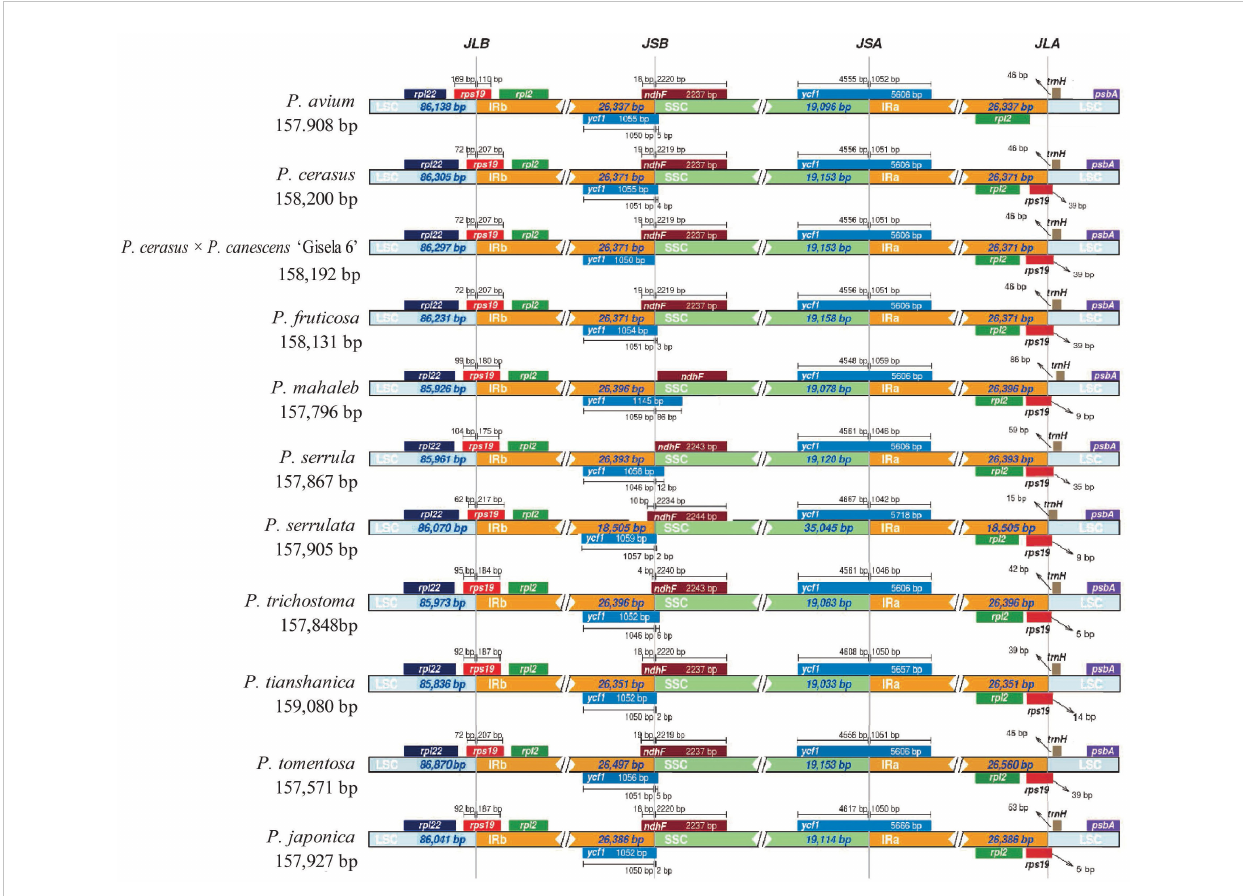
FIGURE 3 Comparison of the inverted repeat (IR)/large single copy (LSC) boundaries and IR/short single copy (SSC) boundaries among chloroplast genomes of 11 Cerasus species. JLA and JLB indicate the junction sites between the SSC and the two IRs (IRA and IRB); JSA and JSB denote the junction sites between the SSC and the two IRs.